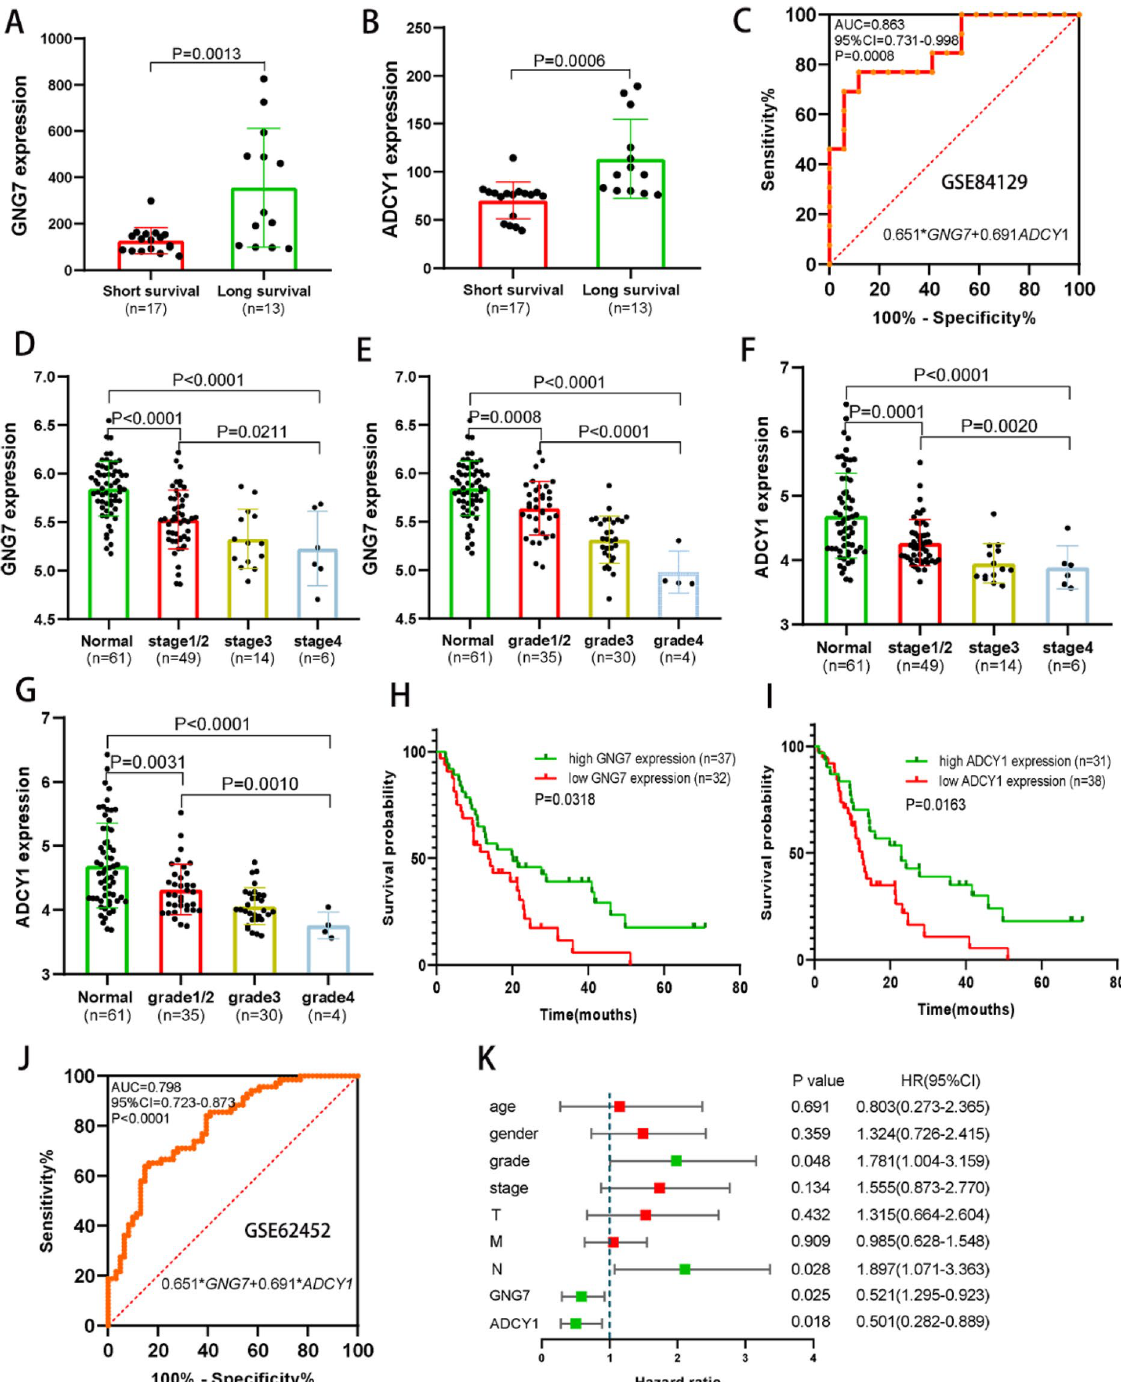
Figure 7. Diagnostic and prognostic value of GNG7 and ADCY1 in the GSE84129 and GSE62452 datasets. ( A , B ) PAAD patients with high survival time have significantly higher mRNA expression of GNG7 ( A ) and ADCY1 ( B ) than patients with short survival time. ( C ) The ROC curve showed that the combined expression of GNG7 and ADCY1 has diagnostic value for PAAD in the GSE84129 dataset (AUC = 0.863, P = 0.0008). ( D – E ) The GNG7 ( D ) and ADCY1 ( E ) mRNA expression was incrementally downregulated with increasing tumor stages. ( F , G ) The GNG7 ( F ) and ADCY1 ( G ) mRNA expression was incrementally downregulated with increasing neoplasm histology grades. ( H , I ) PAAD patients with high expression of GNG7 ( H ) and ADCY1 (I) have a longer survival time than patients with low expression. ( J ) The ROC curve showed that the combined expression of GNG7 and ADCY1 has diagnostic value for PAAD in the GSE62452 dataset (AUC = 0.798, P < 0.0001). ( K ) Low expression of GNG7 and ADCY1 were independent risk factors for OS of PAAD